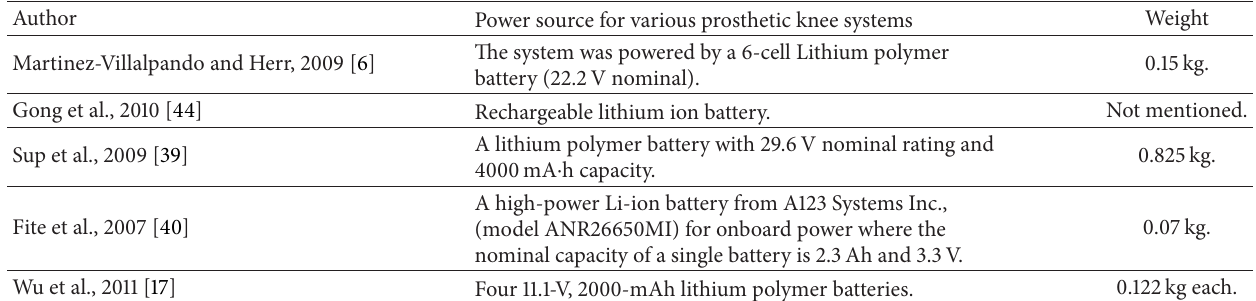
Table 5: Power sources in the prosthetic knee